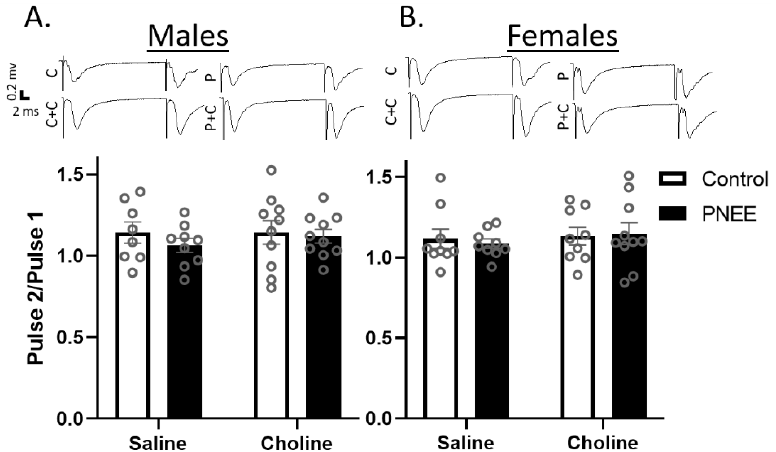
Figure 2. No changes in PPR with PNEE or choline treatment. The average paired pulse ratios (slope of pulse 2/pulse 1) are presented as bar graphs with individual data points as small circles for ( A ) male and ( B ) female offspring in all conditions. (C) Control + saline; (C + C) control + choline; (P) PNEE + saline; and (P + C) PNEE + choline. Representative paired pulse fEPSP traces are shown above each graph. Error bars are ± SEM.